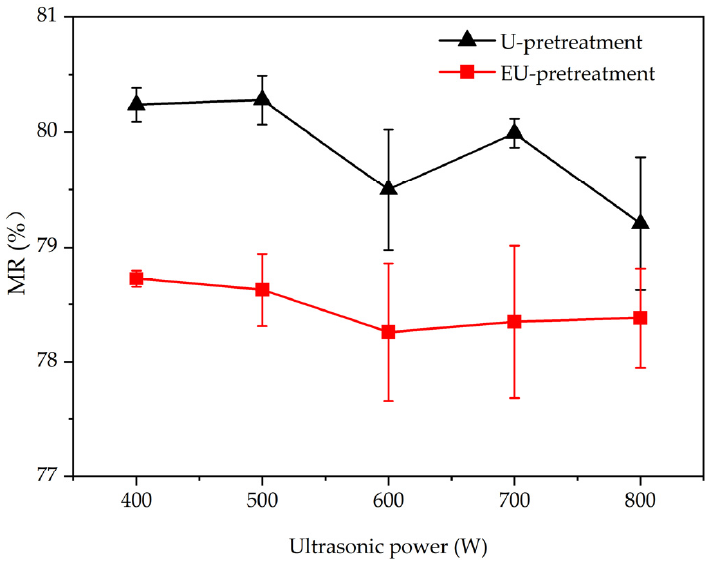
Figure 2. Effect of ultrasonic power on moisture of ginkgo fruits.